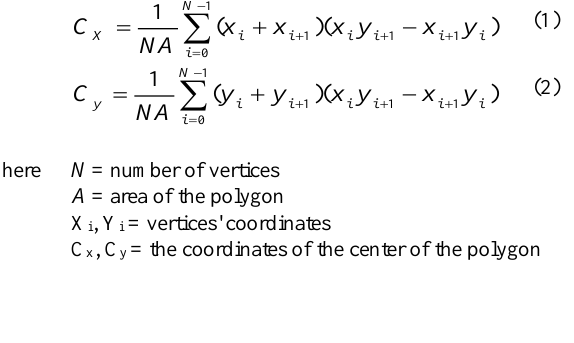
Figure 4. The designed web-GIS system for registering citizens' spatial